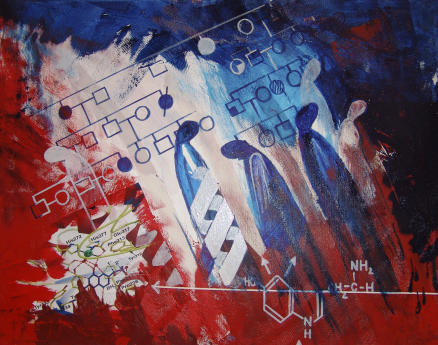
Colours of Depression(Illustration: Raj Ramesar)